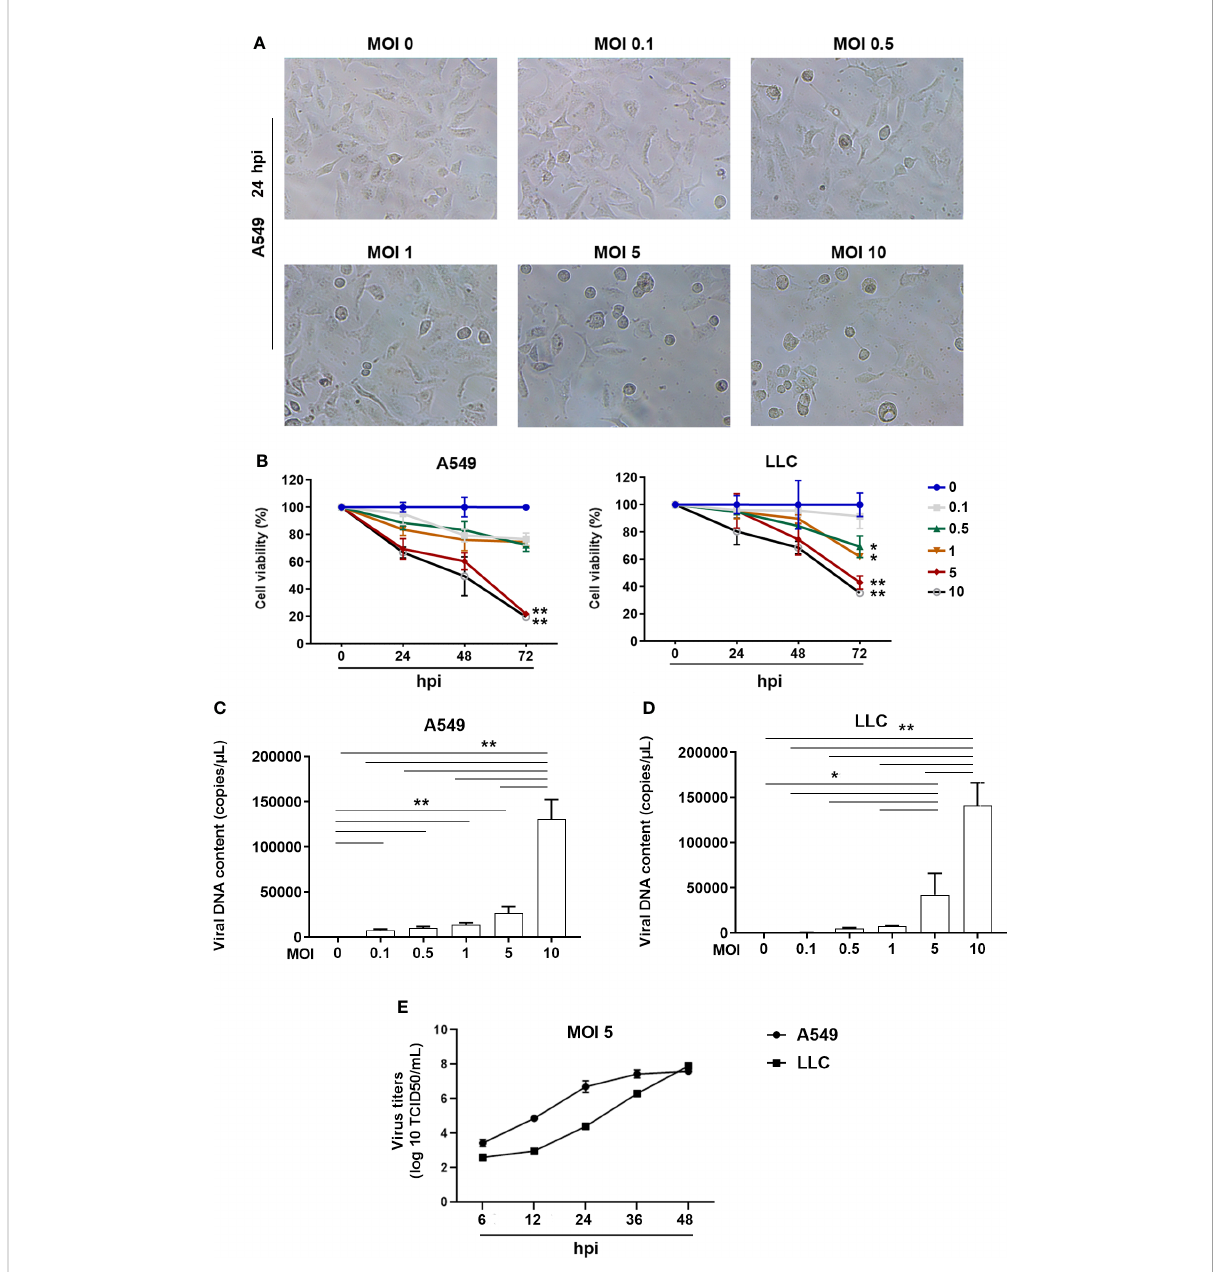
FIGURE 1 ORFV NA1/11 infection causes oncolysis of lung cancer cells. (A) Morphological changes in A549 cells following infection with, or without, ORFV NA1/11 at the indicated MOIs for 24 hours. (B) WST-8 assays measured the cell viability after infection in triplicate with, or without, ORFV NA1/11 at the indicated MOIs for the varying periods. The uninfected cells were designated as 100%. (C, D) qPCR evinced that the infected viruses replicated in lung cancer cells. Data are representative images or expressed as the mean ± SD of each group from three separate experiments. (E) Time course of viral replication in A549 and LLC cells after infection of ORFV (MOI 5). Data are representative images or expressed as the mean ± SD of each group from three separate experiments. *P<0.05,